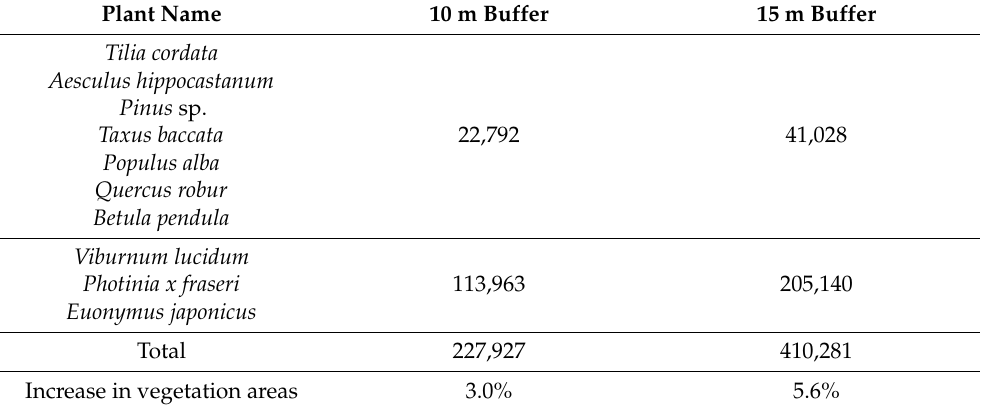
Table 5. Possible number of